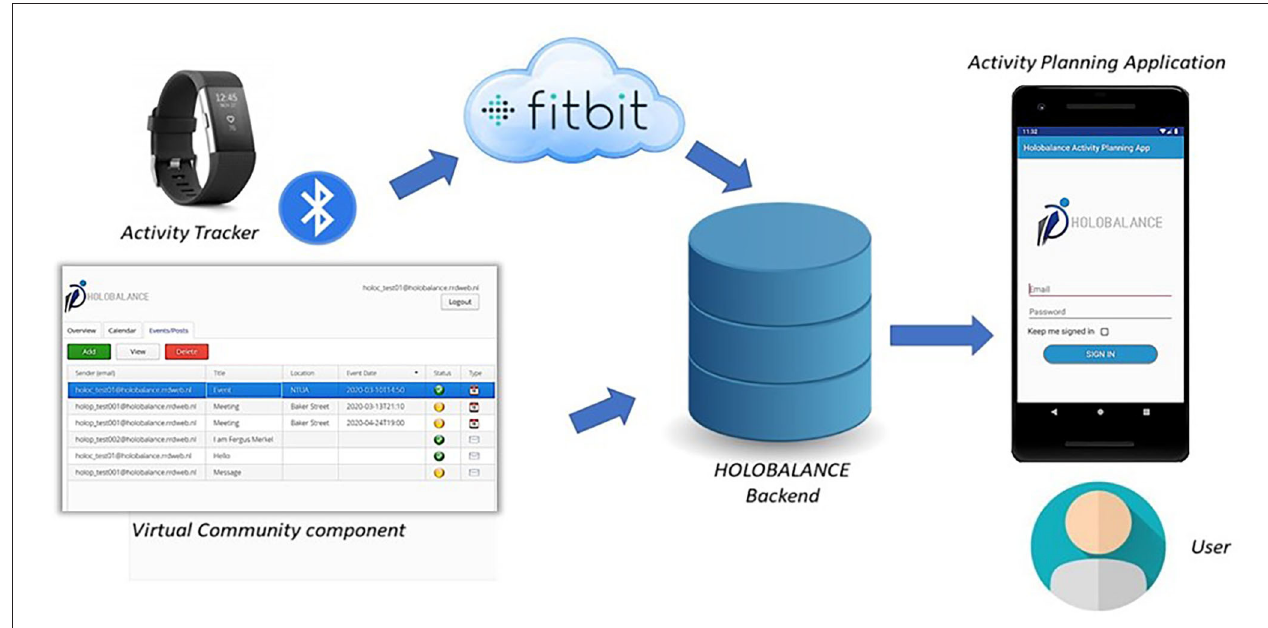
FIGURE 2 | Activity Planning Application in the HOLOBALANCE system.